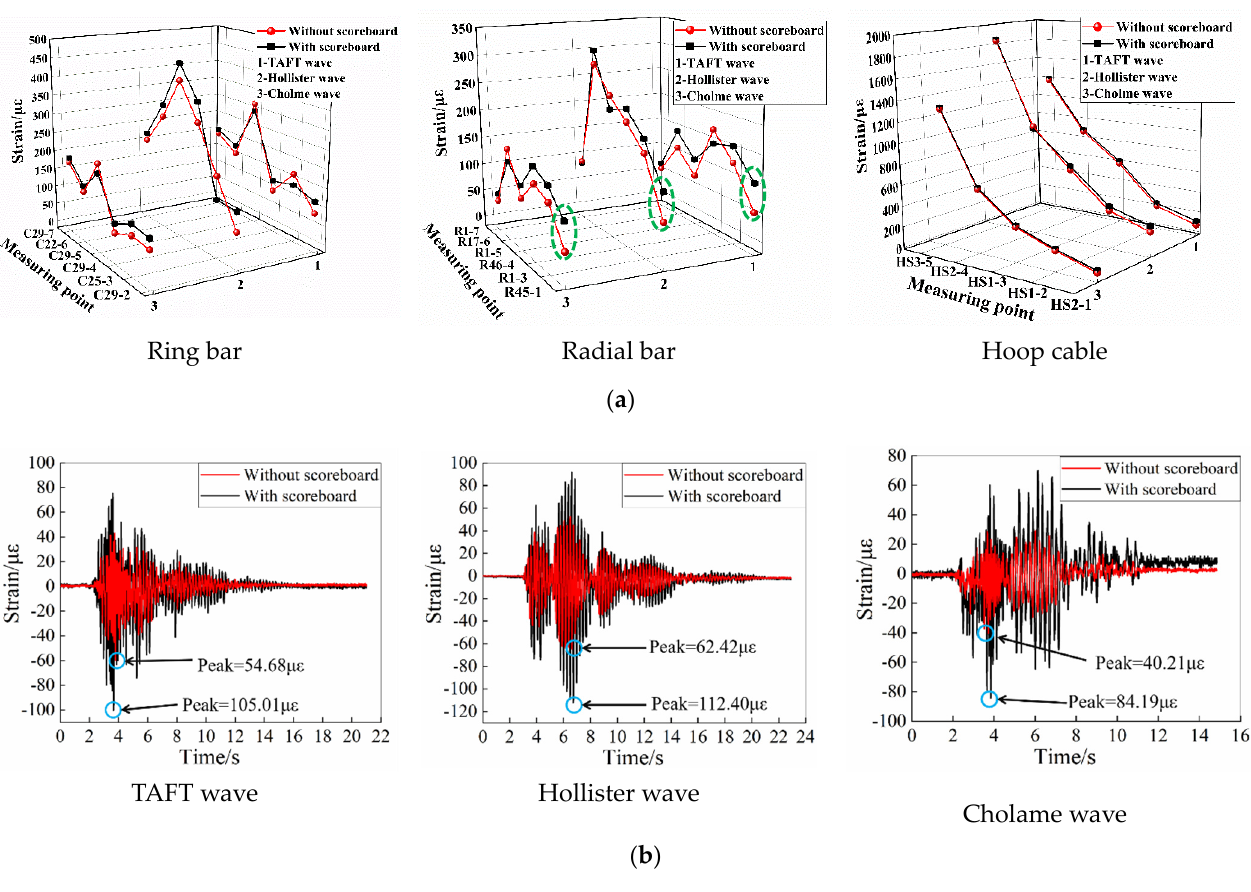
Figure 17. Strain response comparison: ( a ) Peak strain; ( b ) Strain time-history curves of measuring point R45-1.